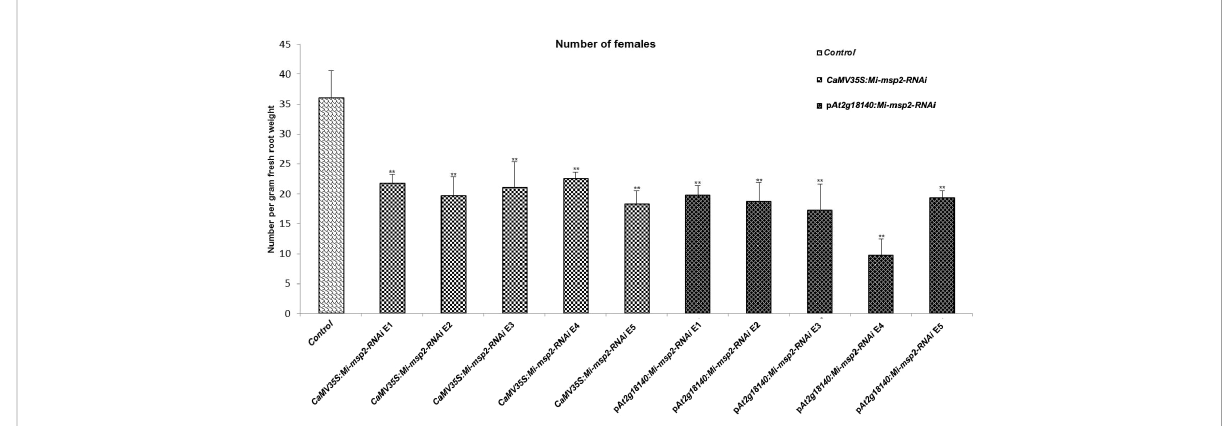
diameter for females isolated from the CaMV35S::Mi-msp2-RNAi and p At2g18140::Mi-msp2-RNAi lines was 32% in both cases (Figure 6A). The reduction in the average area for females isolated from the CaMV35S::Mi-msp2-RNAi lines was recorded as 55% and for the p At2g18140::Mi-msp2-RNAi lines as 56% compared to the females isolated from the control plants (Figure 6B). In previous studies the reduction in female width and area for Mi-msp2 RNAi lines was reported to be 32.2% and 54.8%respectively(Joshietal.,2019).Theseresultsindicatethatthe Mi-msp2 gene driven by both promoters affected the development offeeding M. incognita females.